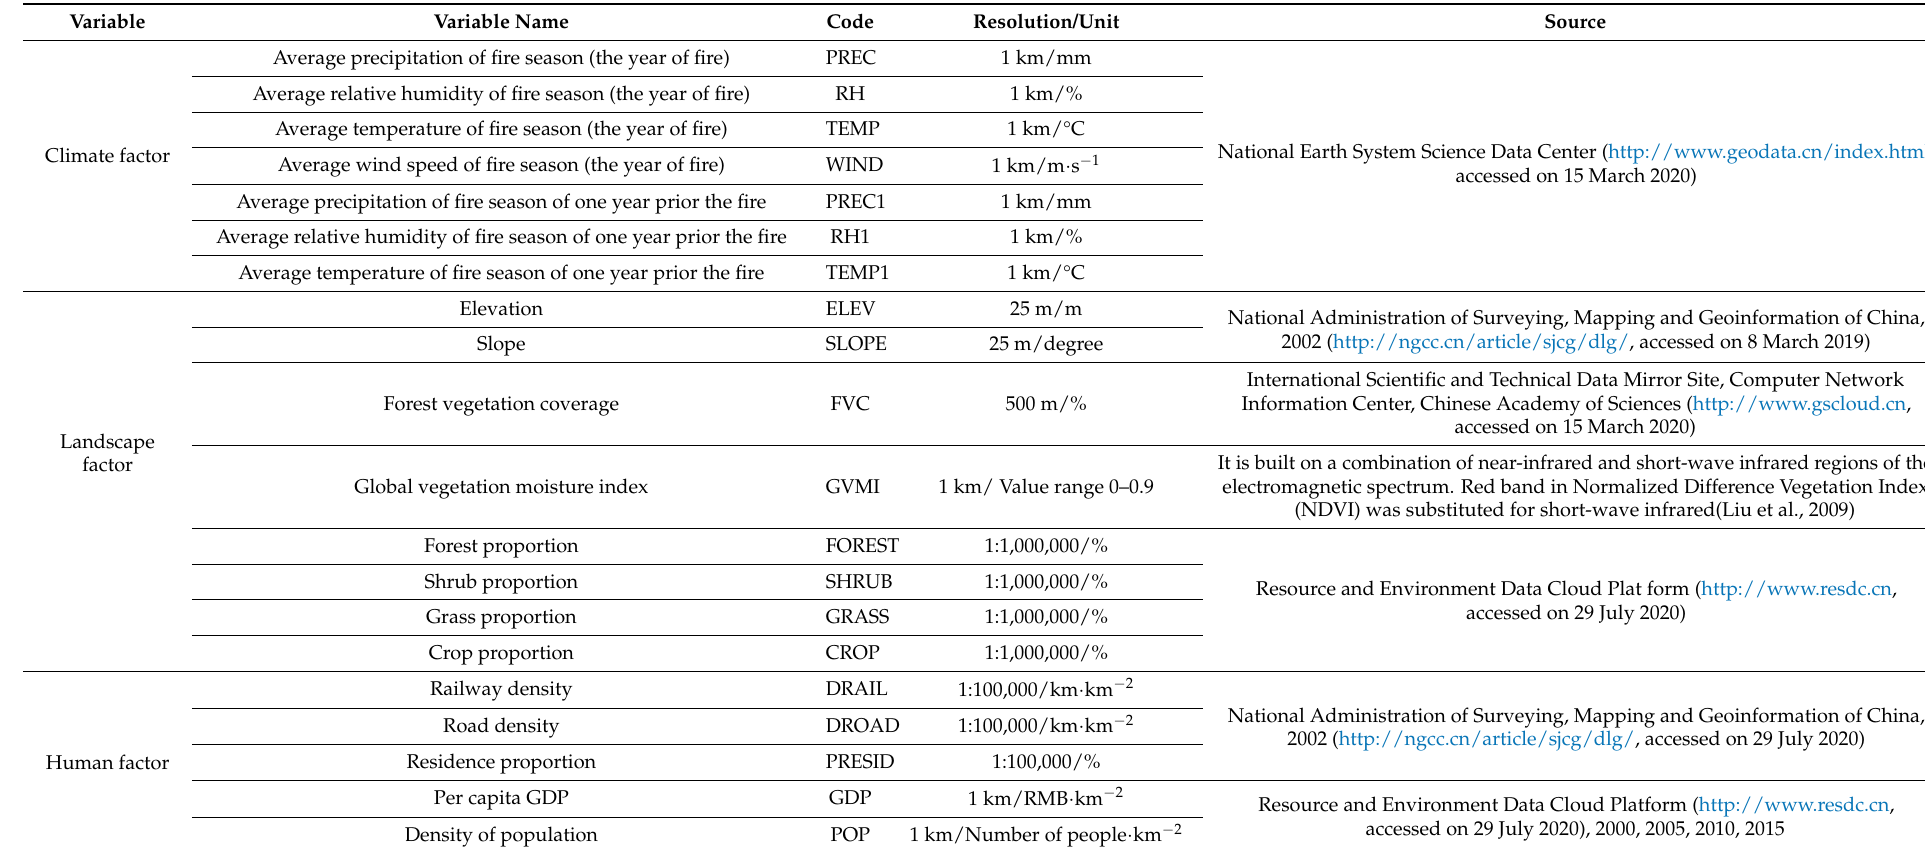
Table 2. Independent variables included in forest fire model development for Random